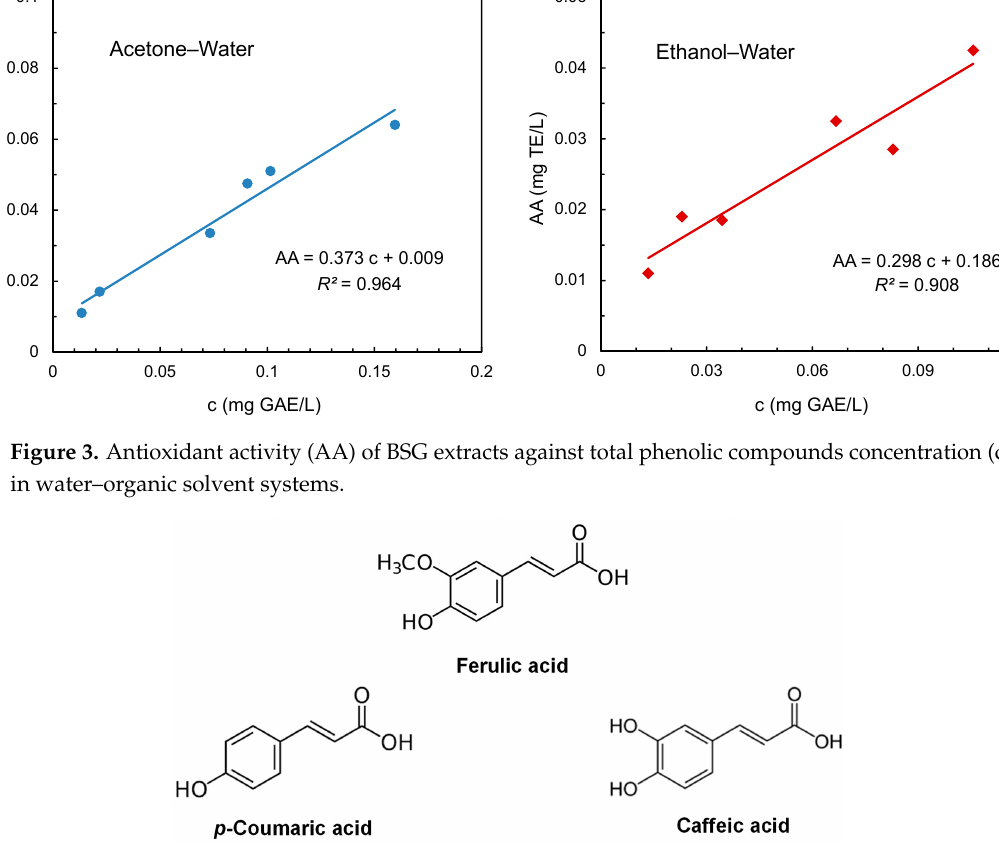
Figure 4. Molecular structures of the three major phenolic compounds in BSG. Table 2. Molecular properties and Hansen solubility parameters of solvent components (MW: molecular weight; MV: molar volume; δ i : Hansen solubility